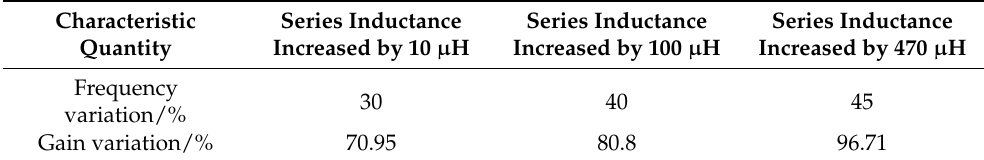
Table 16. The variation of the first peak frequency and amplitude